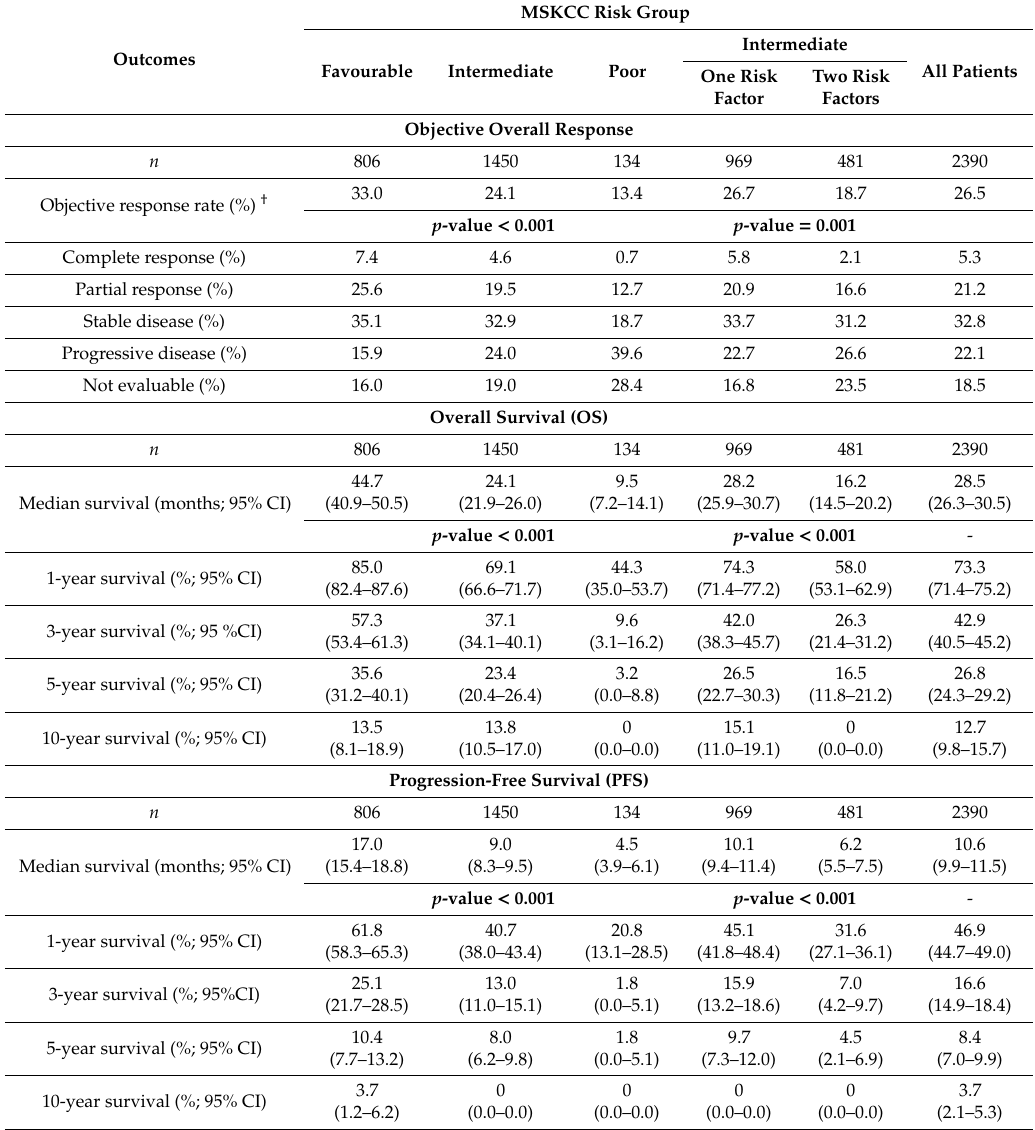
Table 2. Overall response rate (ORR), overall survival (OS), and progression-free survival (PFS) results for sunitinib treatment according to MSKCC risk